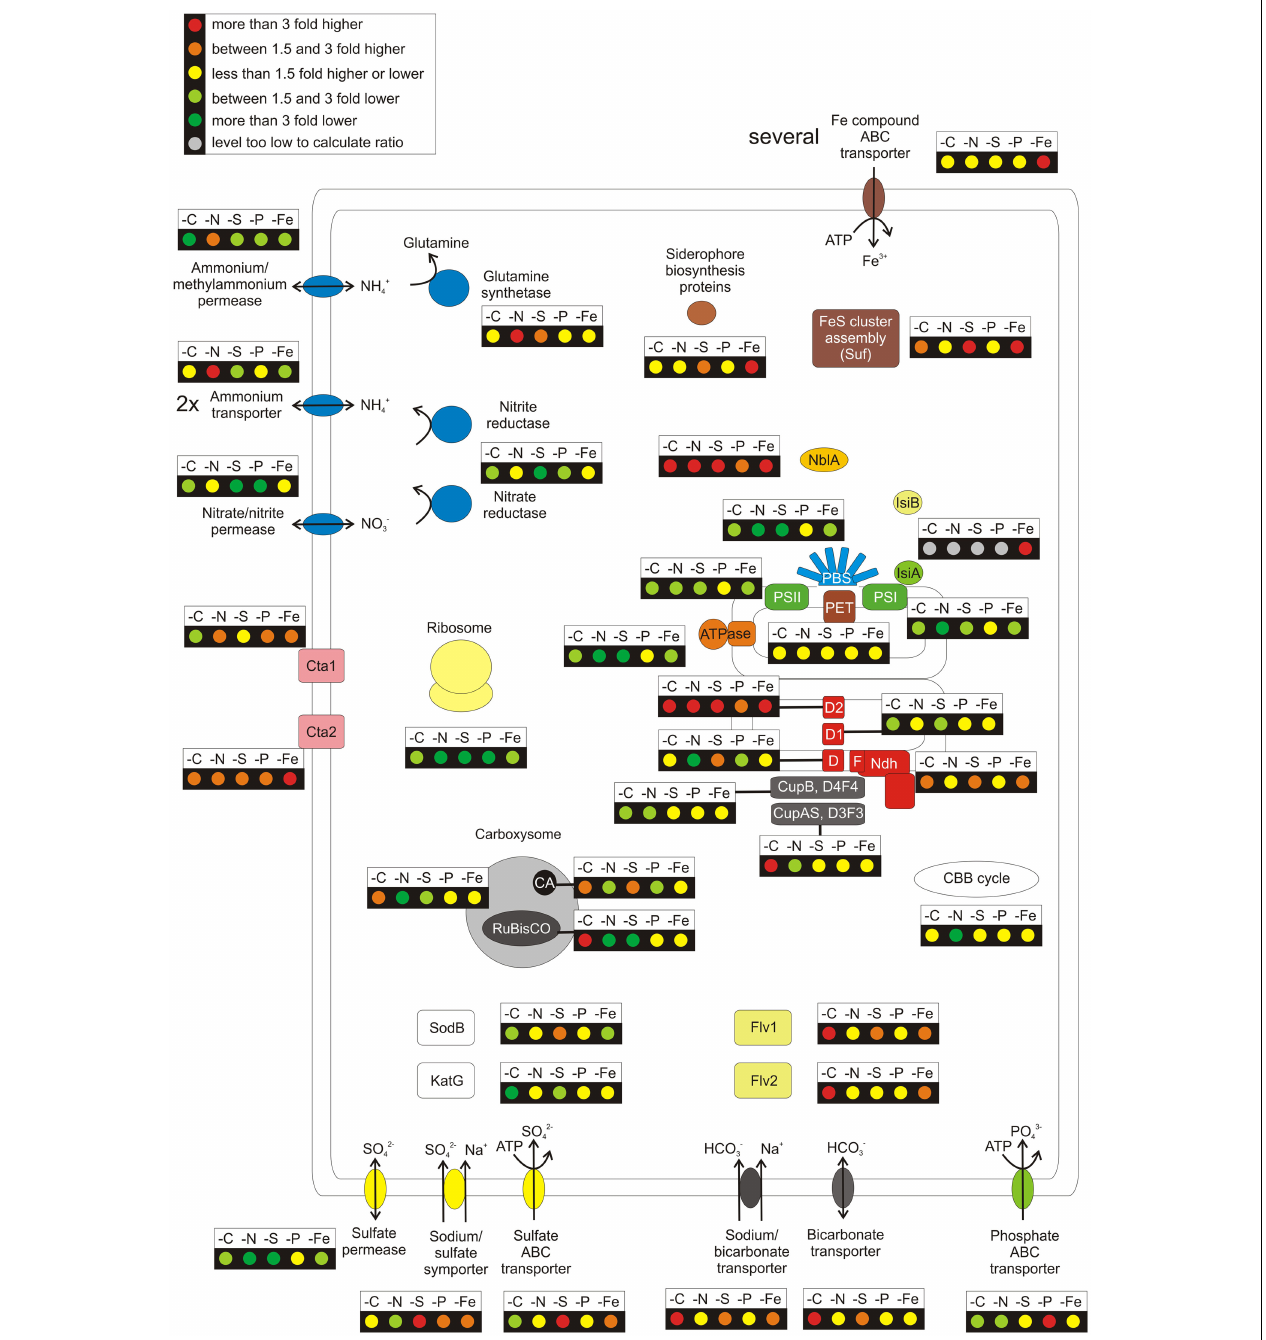
transport chain, the carboxysome, the Calvin–Benson–Bassham cycle, the NADH dehydrogenase complex, the F 0 F 1 type ATP synthase, the terminal oxidases, and the ribosome. Further, the genes coding for uptake systems for ammonia, nitrate, sulfate, phosphate ( pstABCS ), and iron (all genes listed in Table S3 in Supplementary Material except those for regulation, siderophore biosynthesis, and Fe–S cluster assembly) are shown.The nitrate and nitrite reductases and the glutamine synthetases ( glnA , glnN ), the siderophore biosynthesis (SYNPCC7002_G0019-G0023), and Fe–S cluster assembly ( sufBCDS ) are highlighted. Finally, the changes in the transcript levels of two flavoproteins, the superoxide dismutase, and catalase are